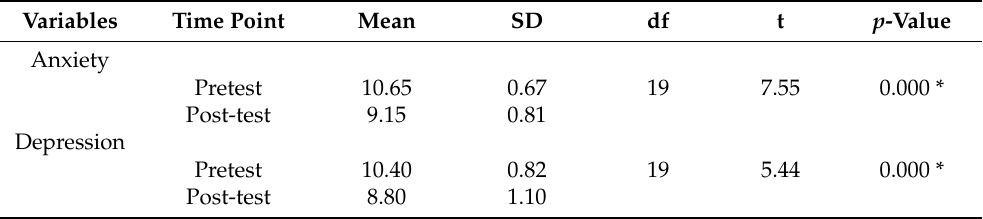
Table 4. Comparison of anxiety and depression scores at each point of measurement in experimental group ( n = 20).